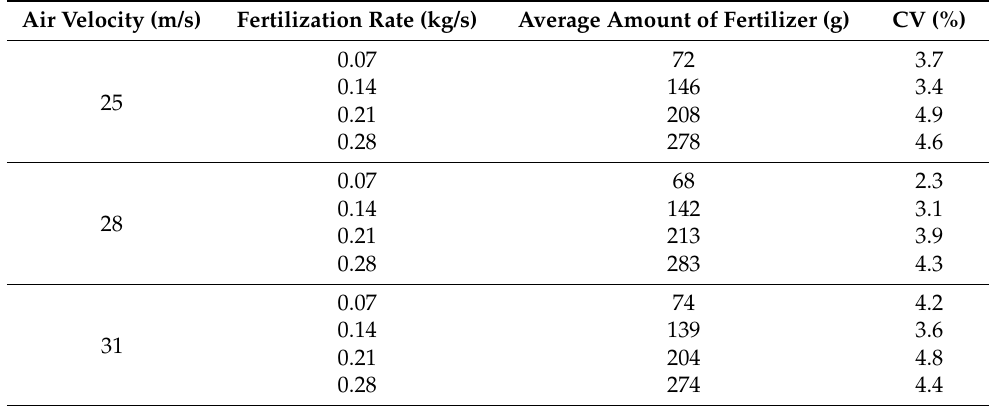
Table 6. Results of validation